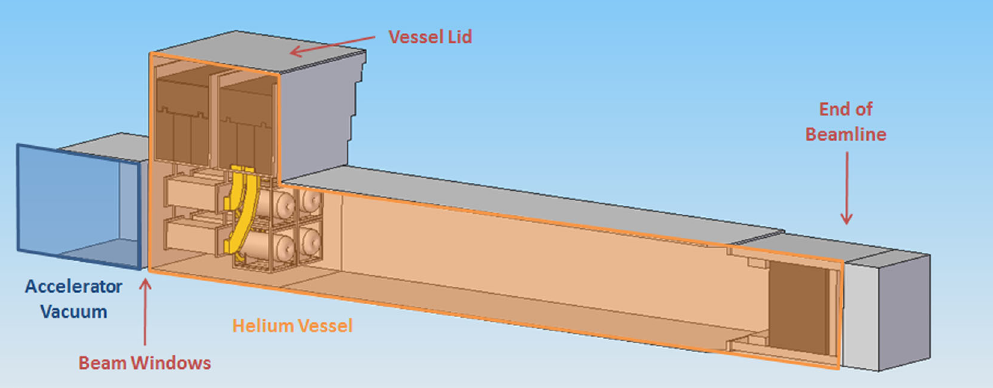
FIG. 9. Extent of helium